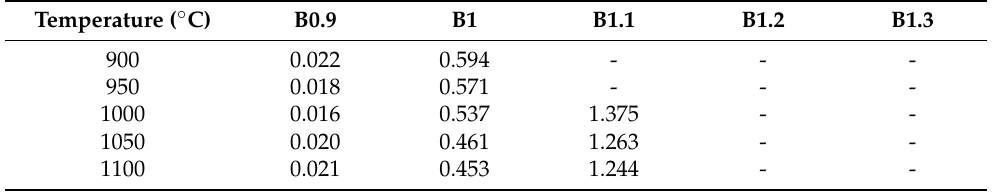
Table 4. Acid corrosion rate of the samples with different formulations treated at 900~1100 ◦ C for 3